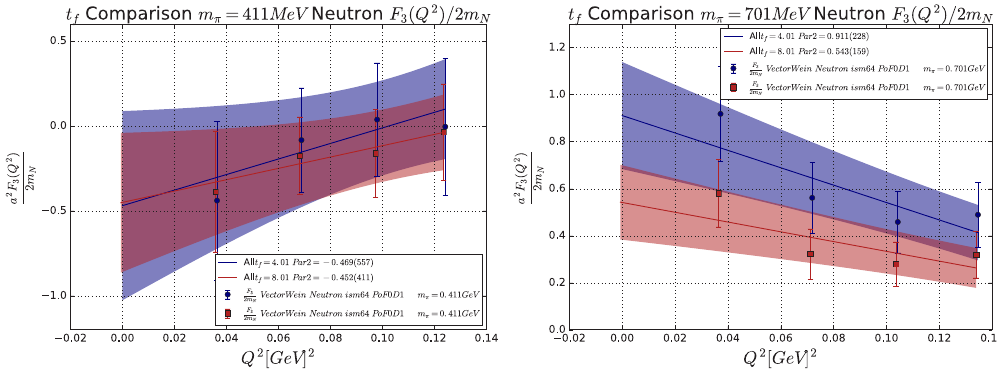
Figure 5. Flow time dependence from t f / a 2 = 4 . 01 (blue) to t f / a 2 = 8 . 01 (red) of the CP-odd vector form factor F 3 / 2 m N in units of α W / Λ 2 , induced via the Weinberg CP-violating vacuum, plotted against transfer momentum Q 2 . Left and right plots show the m π = 411 , 701 MeV results respectively. The linear fit to Q 2 extract the value for the neutron and proton EDM d n / p